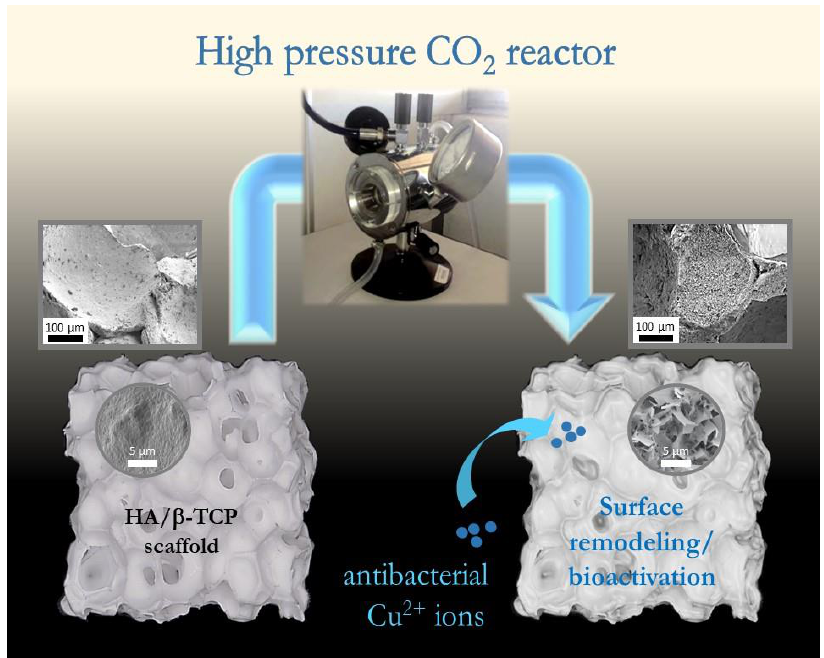
Figure 1. General concept of the study: a high-pressure CO 2 reactor to be used as a tool to remodel the surface of commercial HA/ β -TCP porous scaffolds, leading to high surface reactivity/bioactivity, with the potential addition of antibacterial Cu 2+ ions.